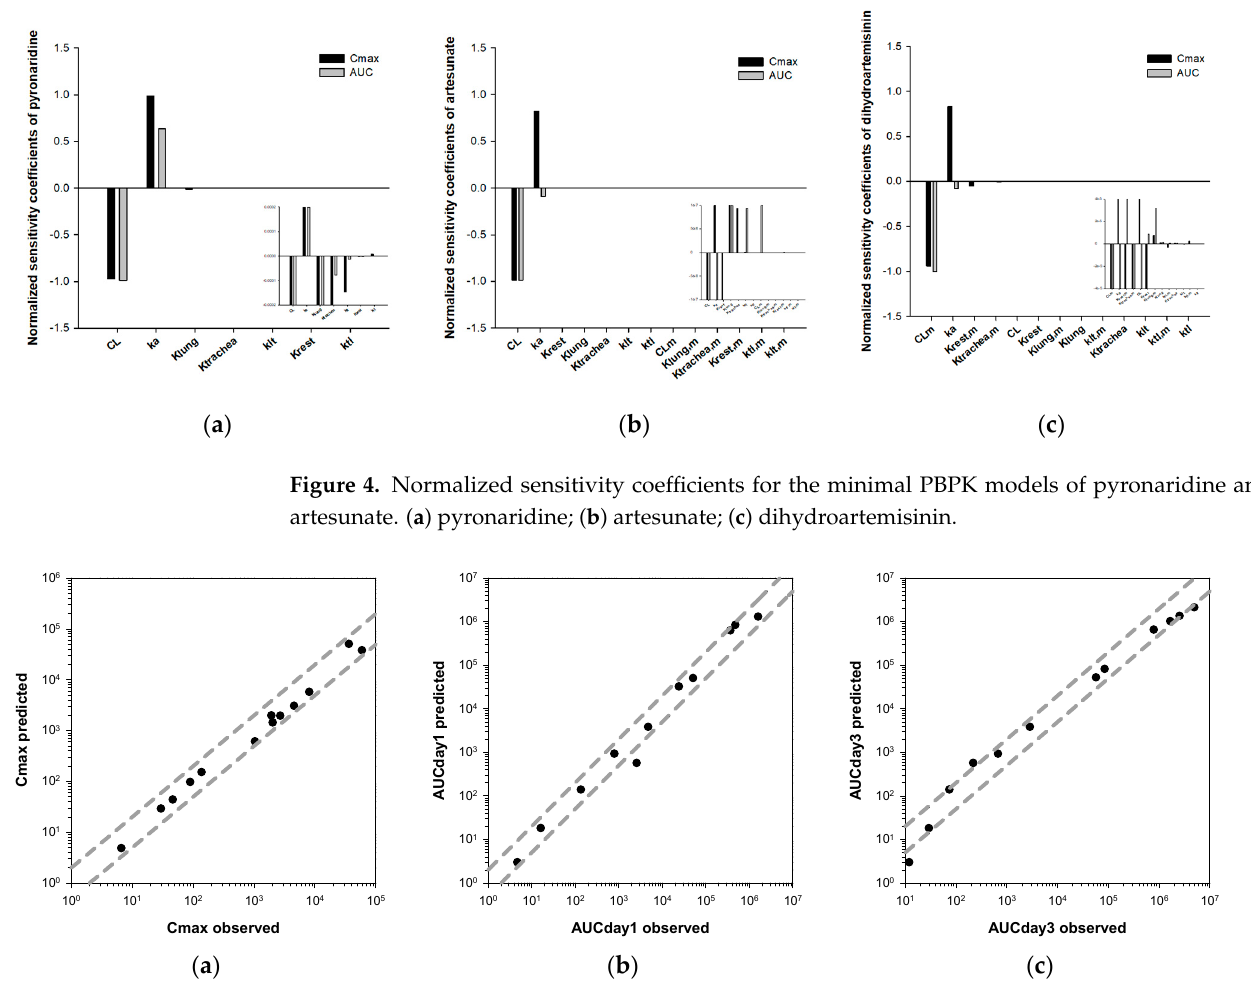
Figure 5. Comparison of the observed and predicted PK parameters. ( a ) C max ; ( b ) AUC Day1 ; ( c ) AUC Day3 . The dashed lines represent 2-fold errors between the observations and predictions.